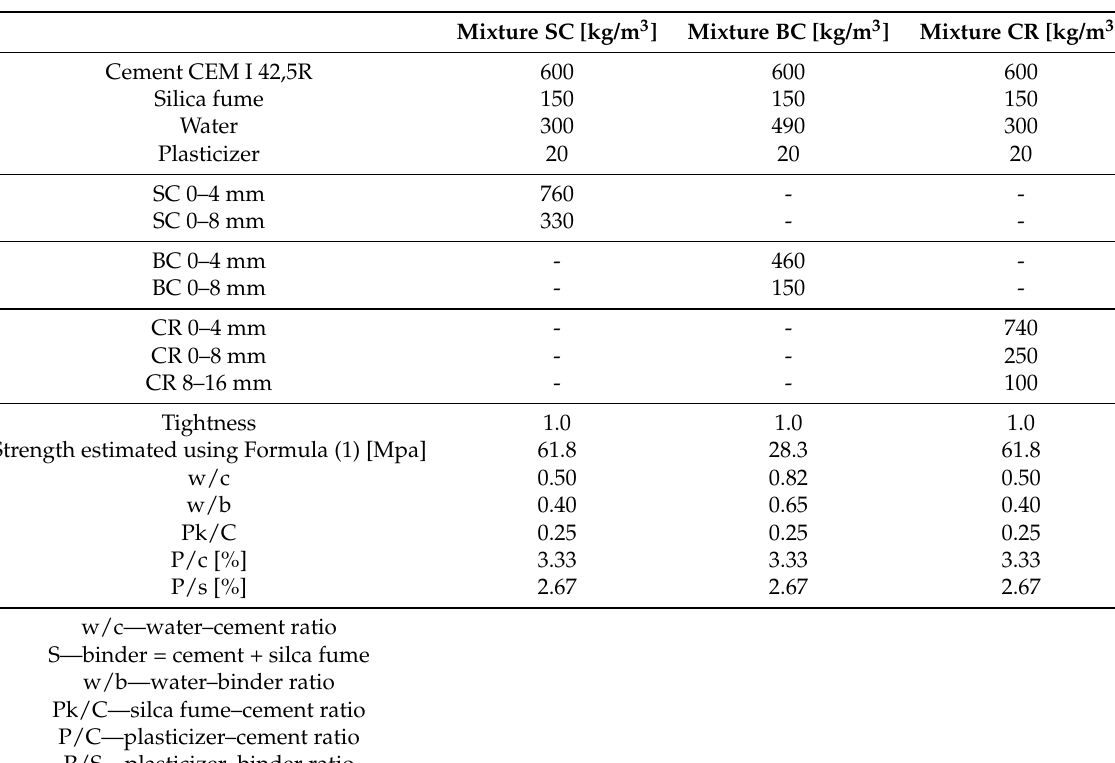
Table 2. Formulas of concrete mixtures.